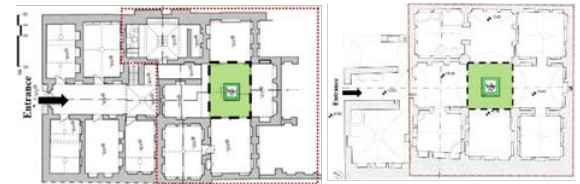
Figure 13. Create a garden in the central courtyard of the house.